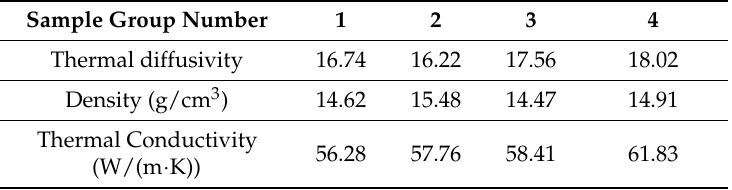
Table 4. Thermal conductivity of WC–Co cemented carbide.